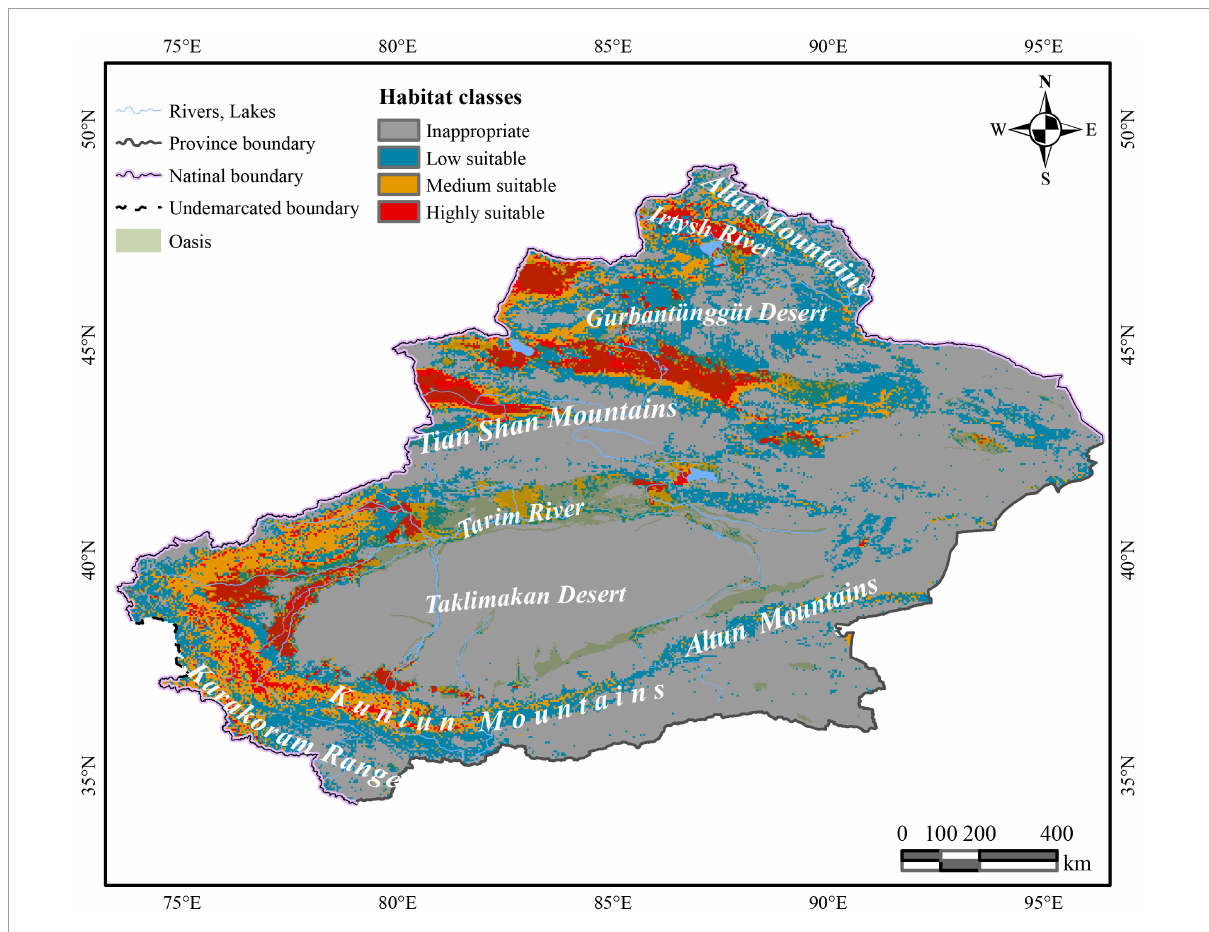
FIGURE2 The predictive distribution of C. salsa with the main mountains and rivers in Xinjiang. The map is made based on the standard map no. GS(2017)1267 downloaded from the standard map service website of the Ministry of Natural Resources, without modification of the base